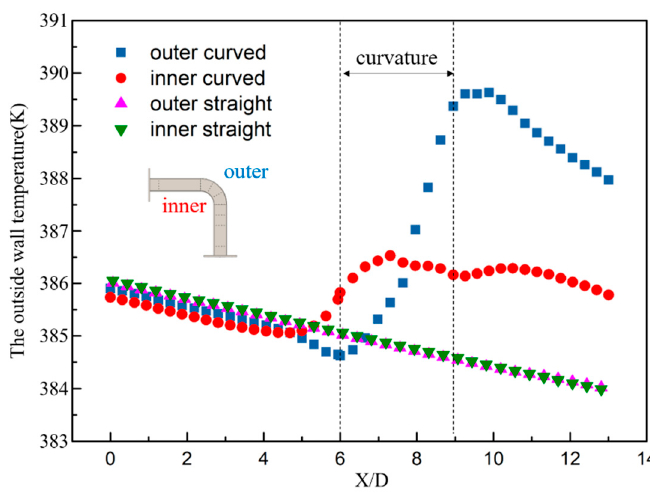
Figure 15. Outside wall temperature in streamwise direction of simulation.